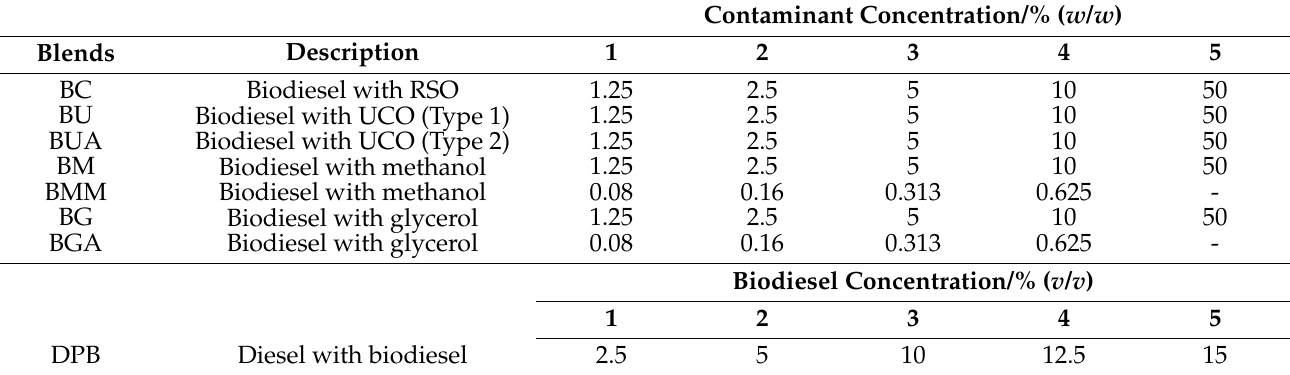
Table 2. Sets of blends prepared and their respective samples’